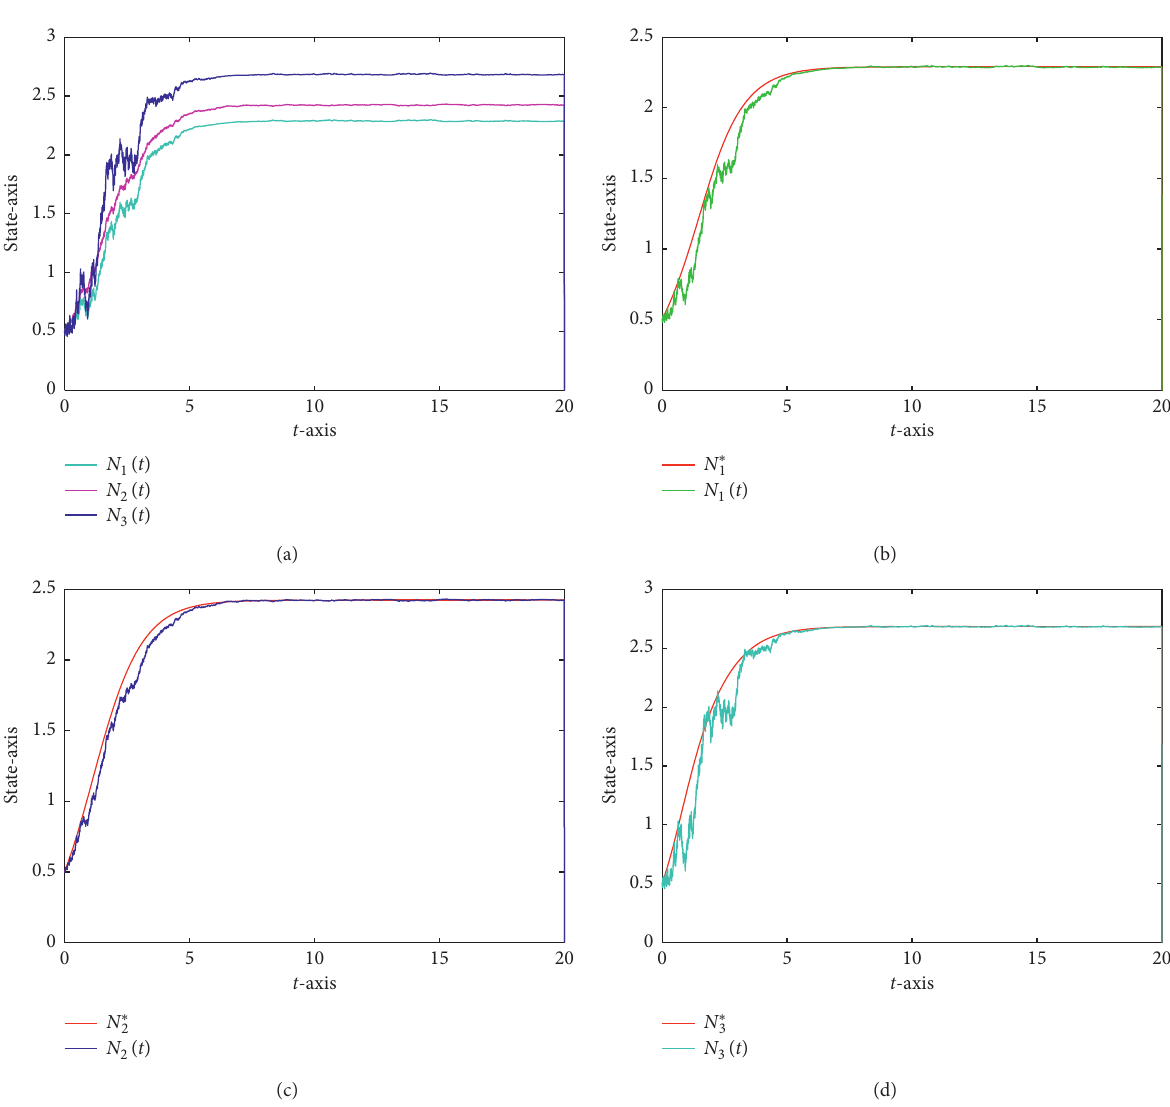
� 0 . 2 , σ � 0 . 1 , σ � 0 . 3 , and τ � 0 . 5: (a) the state graph of three species; (b), (c), and (d) are the 1 2 3 , N , and N around their corresponding equilibrium points N ∗ 1 2 3